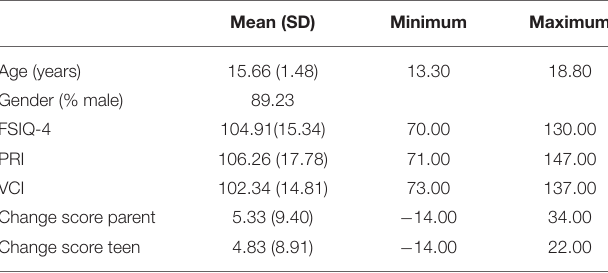
TABLE 1 | Demographic